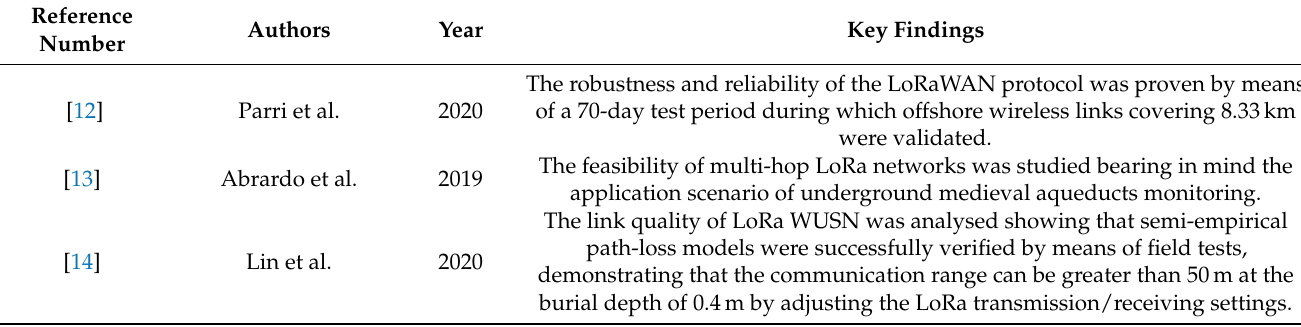
Table 1. Related works key findings